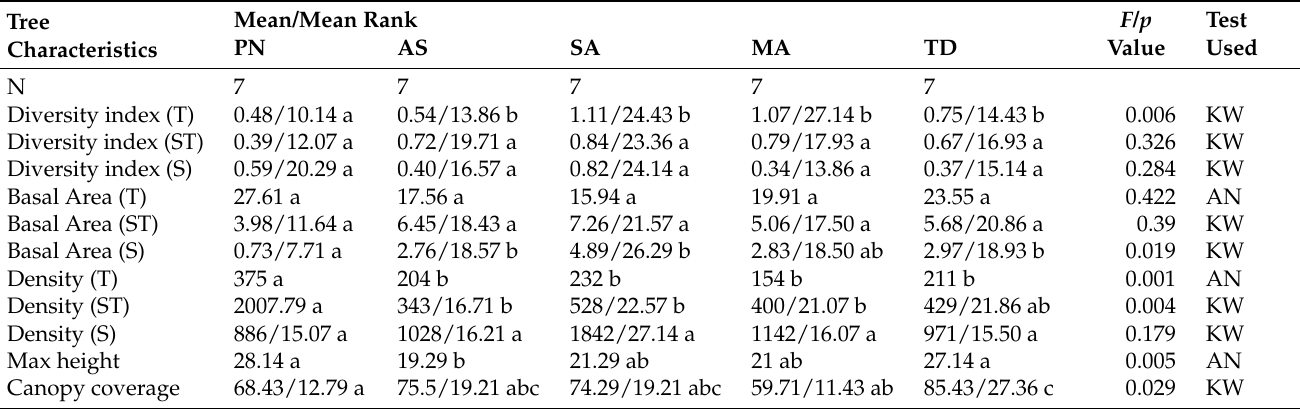
Table 3. Plot-level tree species diversity and structural characteristics of tree species in the protected forest of Kulon Progo Community